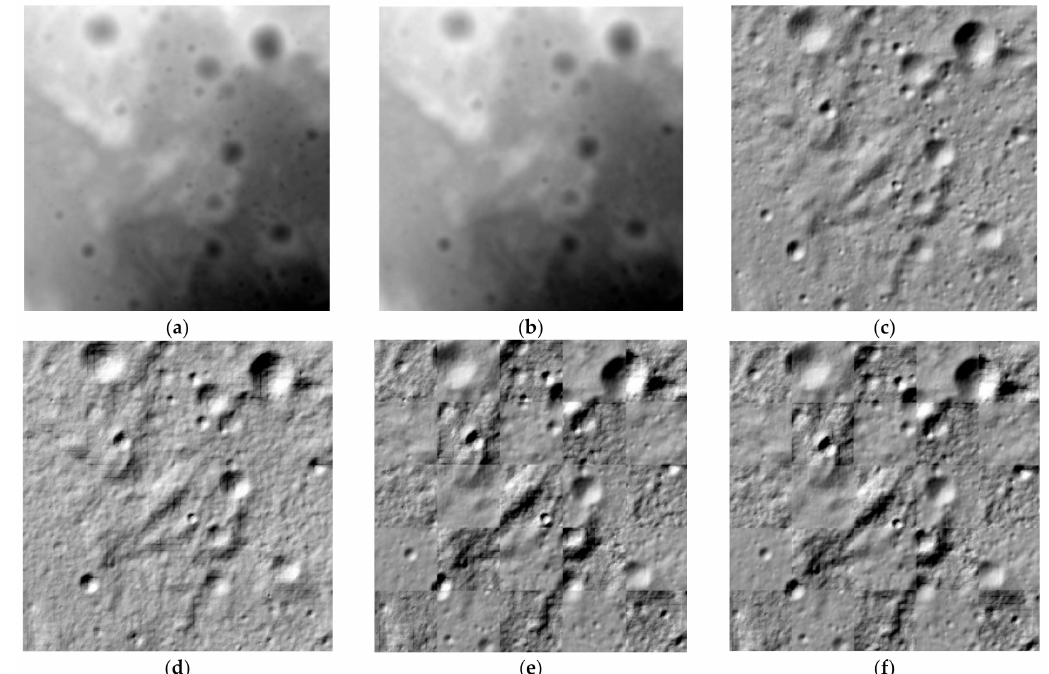
Figure 10. Examples of registration results of SLDEM2015 and CE2TMap2015_DEM_20m in the 0.5 ◦ × 0.5 ◦ block centered at (119.29 ◦ W, 3.72 ◦ N). ( a ) Reference DEM; ( b ) source DEM; ( c ) reference simulated image; ( d ) source simulated image; ( e ) checkerboard composite of the reference and the pre-registered source simulated images; ( f ) checkerboard composite of the reference and the registered source simulated